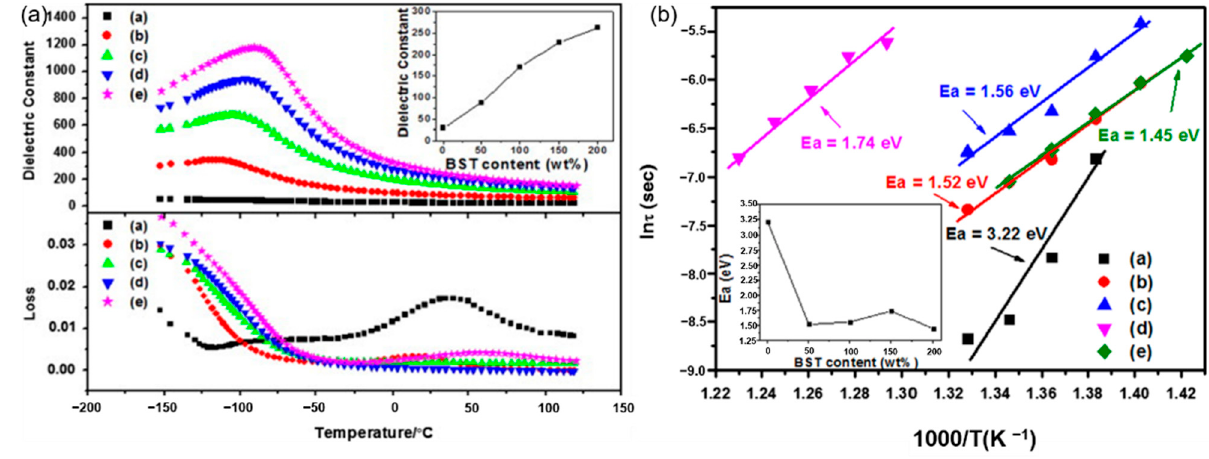
Figure 2. ( a ). Temperature dependence of permittivity and dissipation factor of (a) G-0 (b) G-50 (c) G-100 (d) G-150 and (e) G-200 (measured at 1 MHz). Inset: permittivity at room temperature of the samples. ( b ). Weibull plots of dielectric breakdown strength of (a) G-0 (b) G-50 (c) G-100 (d) G-150 and (e) G-200 ( E a : average dielectric breakdown strength). Inset: E a of the samples. Reprinted with permission from [9]. Copyright 2013 Elsevier Ltd. and Techna Group S.r.l.